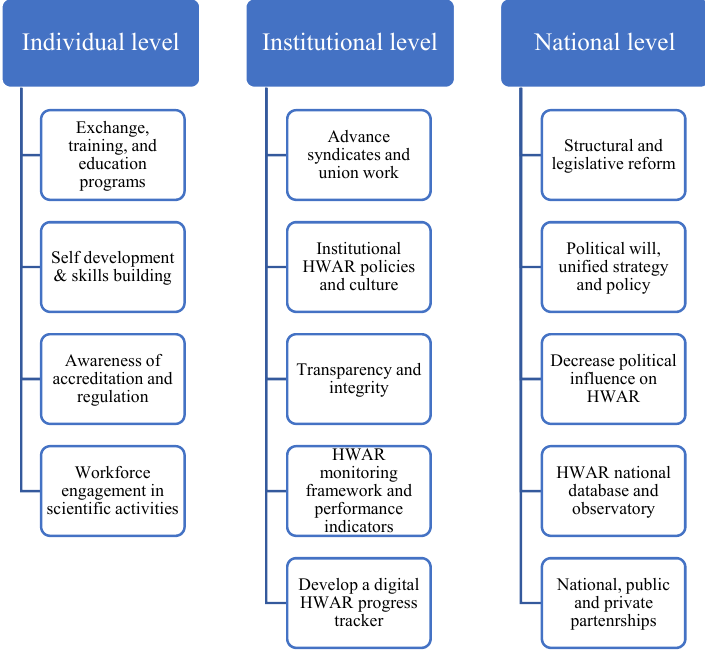
Figure 2. HWAR recommendations on individual, institutional and national levels.